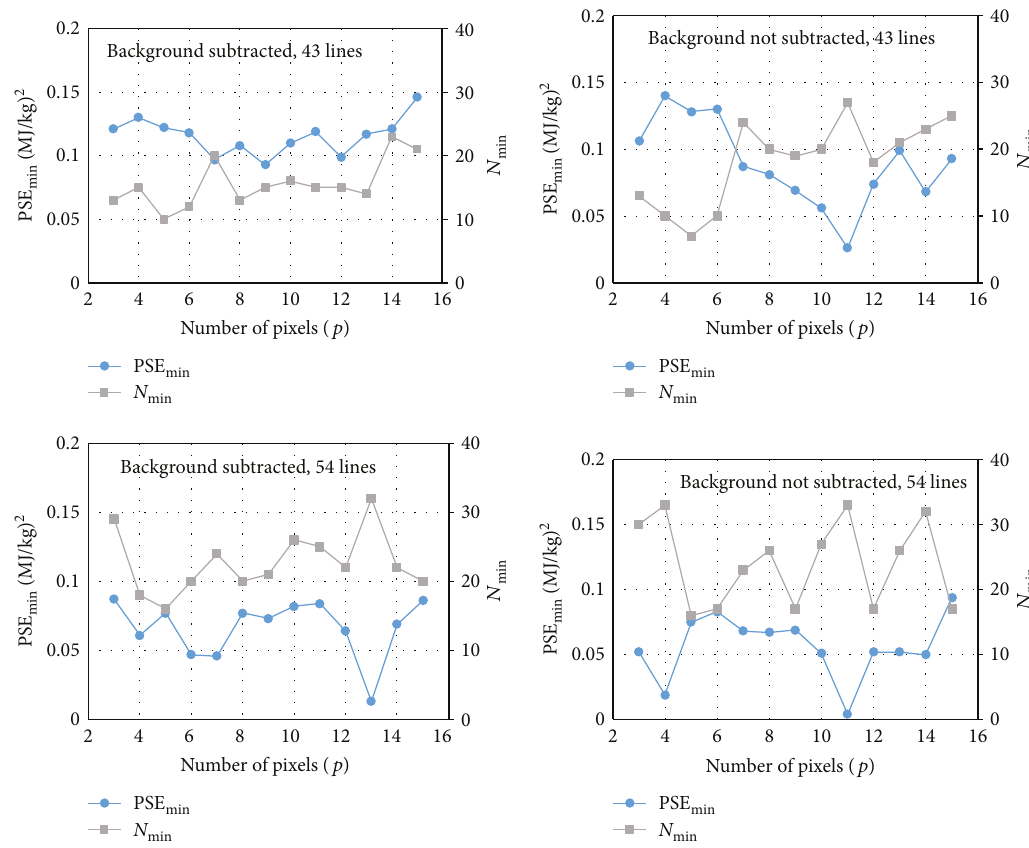
Figure 8: PSE : minimum value of PSE as a function of number of pixels accounted for determination of integral intensities; N min N at minimum PSE.